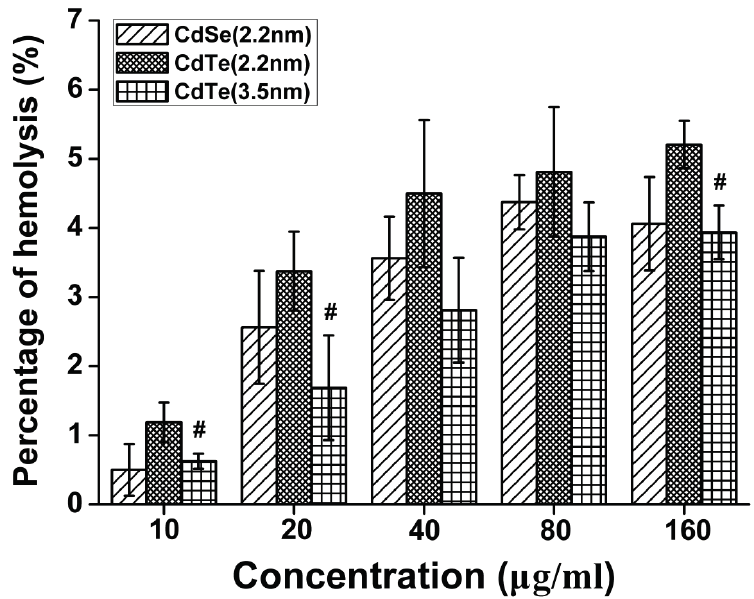
Figure 2. Percentage of hemolysis of RBCs incubated with three types of QDs at different concentrations ranging from 10 to 160 μ g/mL for 30 min. Data are the mean ± SD of three separate experiments. Significance was indicated by: # p < 0.05 vs. 2.2 m CdTe